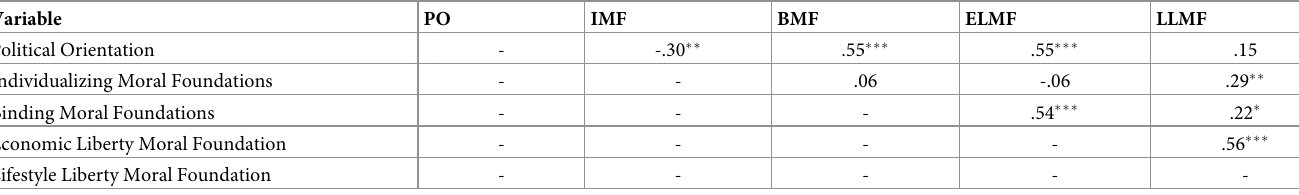
Table 4. Correlation matrix for key political and moral variables in Canadian sample (n = 100).